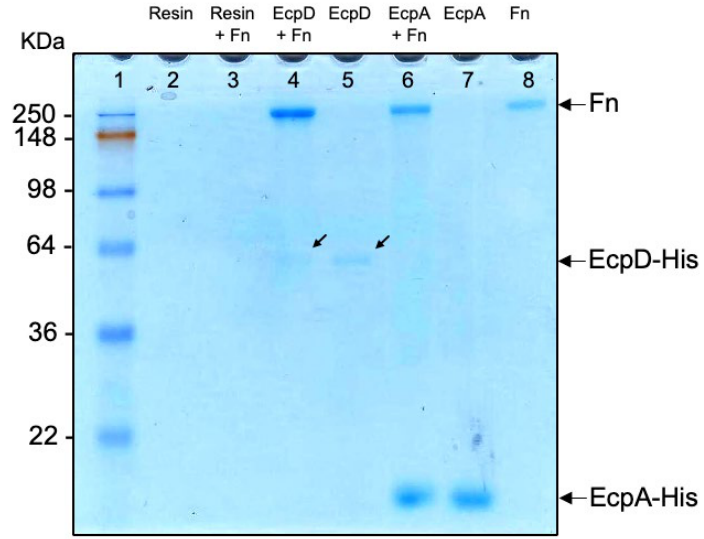
Figure 8. Binding of Ecp proteins to soluble Fn (pulldown assay). His-tagged Ecp proteins (10 µ g/mL) were bound to nickel–NTA resin and then incubated for 1 h with 100 µ L Fn (50 µ g/mL) at room temperature. The resin was washed three times with PBS by centrifugation, resolved in a 10% SDS-PAGE gel, and stained with a Coomassie blue dye. Samples containing only resin (lane 2) and resin plus Fn (lane 3) were worked in parallel as controls. Individual proteins EcpD (lane 5), EcpA (lane 7), and Fn (lane 8) were electrophoresed and used as mass controls. Lane 1, molecular mass standards. The arrows point to EcpD.